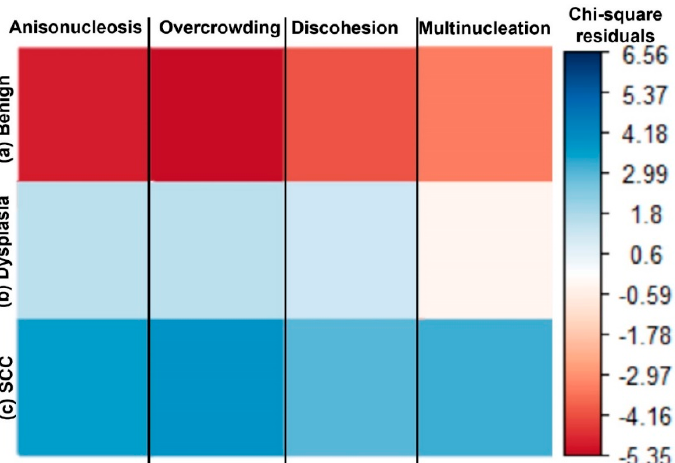
Figure 3. A correlogram developed from Chi-square residuals shows the degree of association between histological gradings and atypic cellular features scored in MPAM image stacks. An increased association with positive residual value is shown in blue and a decrease in association with negative residual values from the Chi-square test is shown in red. Benign sites ( a ) were negatively associated with each atypic feature. Dysplastic sites ( b ) had a positive association with all atypic features, except for the case of multinucleated sites. SCC sites ( c ) displayed a strong, positive association with all atypic features.